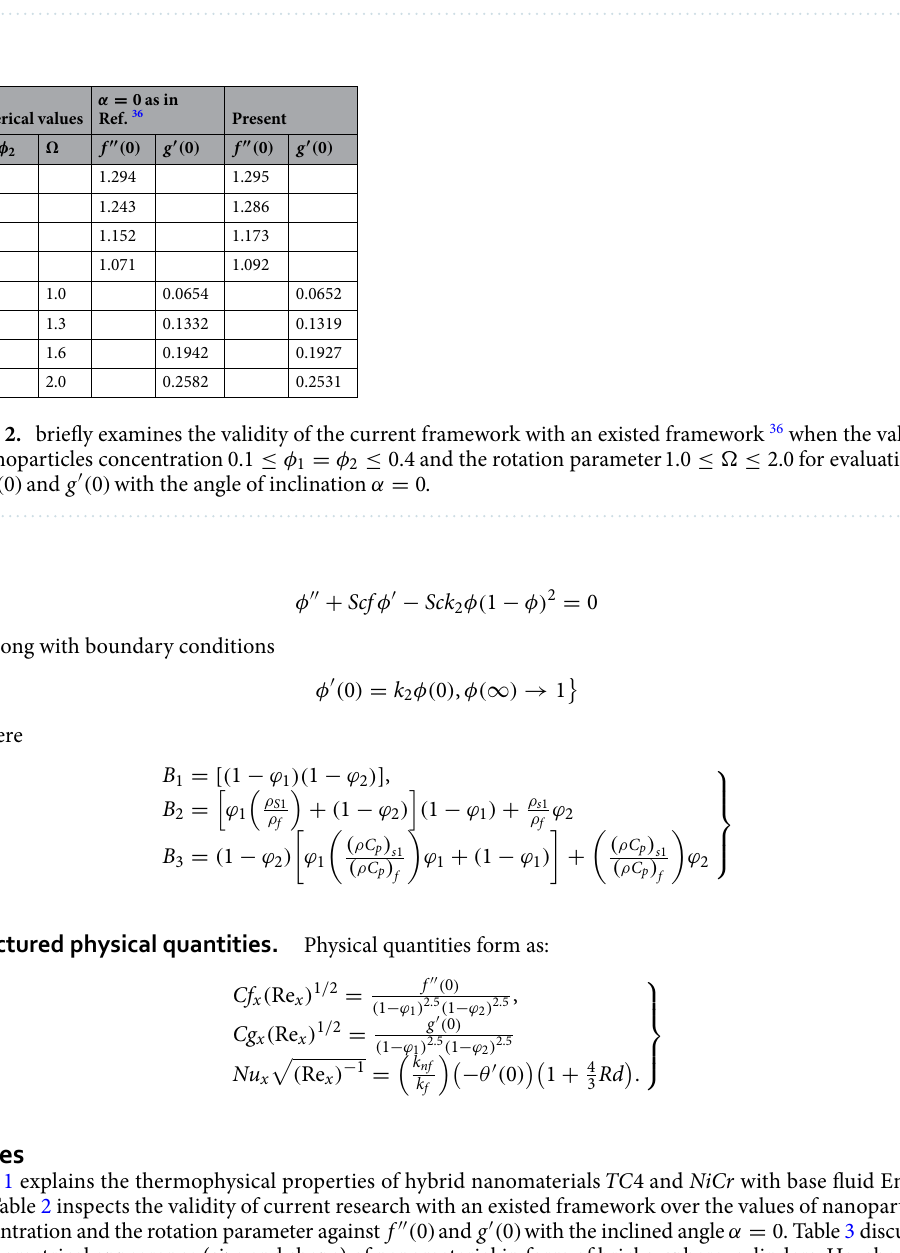
Table 1. explains the thermophysical properties of nanomaterials TC4 and NiCr with base fluid engine oil (unused at 360 K or 1 °C): 40,41 .